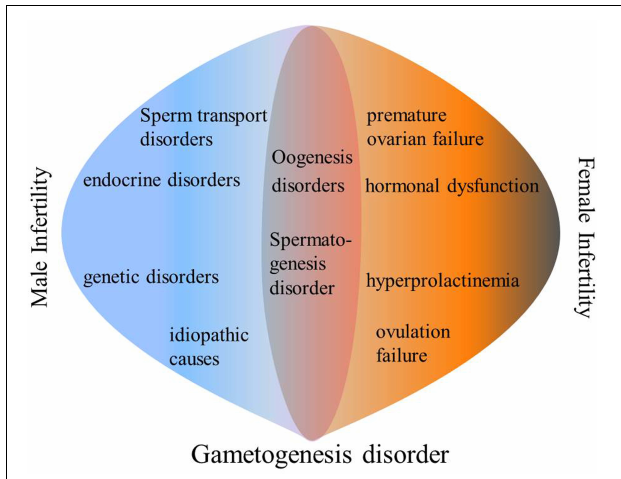
FIGURE 1 | Main causes of